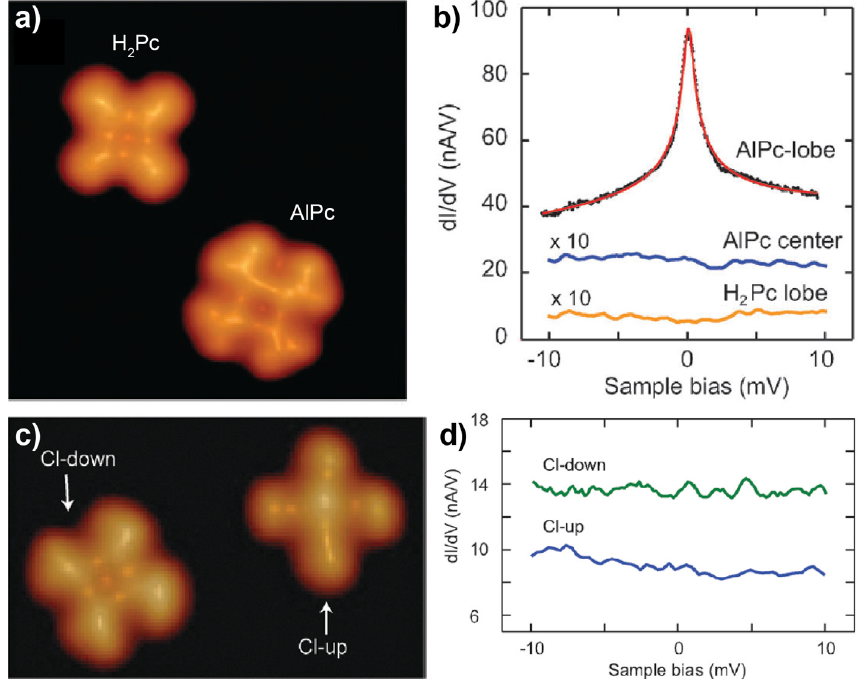
Figure 3. ( a ) STM image of H 2 Pc (top-left) and AlPc (bottom-right) on Au(111). ( b ) d I / d V spectra of H 2 Pc and AlPc. ( c ) STM image of ClAlPc. ( d ) d I / d V spectra of ClAlPc in either a Cl-up or a Cl-down configuration. Adapted from [57], with permission from the Royal Society of Chemistry, 2016. Pc: phthalocyanine.